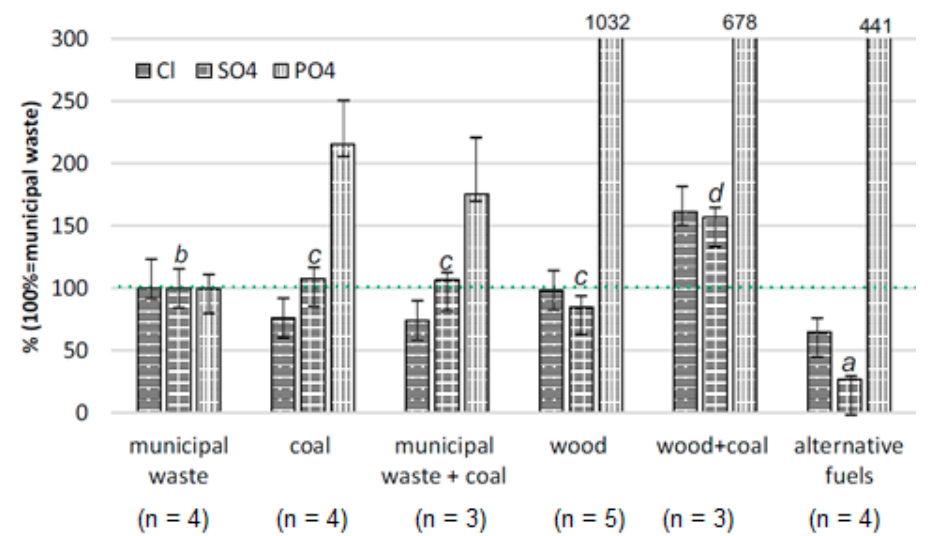
Figure 4. Comparison of the content of Cl − , SO 4 2 − , and PO 4 3 − in ashes: wood, coal, and alternative fuels in relation to the content in ashes from municipal waste burned in home furnaces: n —number of samples; statistically significant differences marked, for p = 0.05.